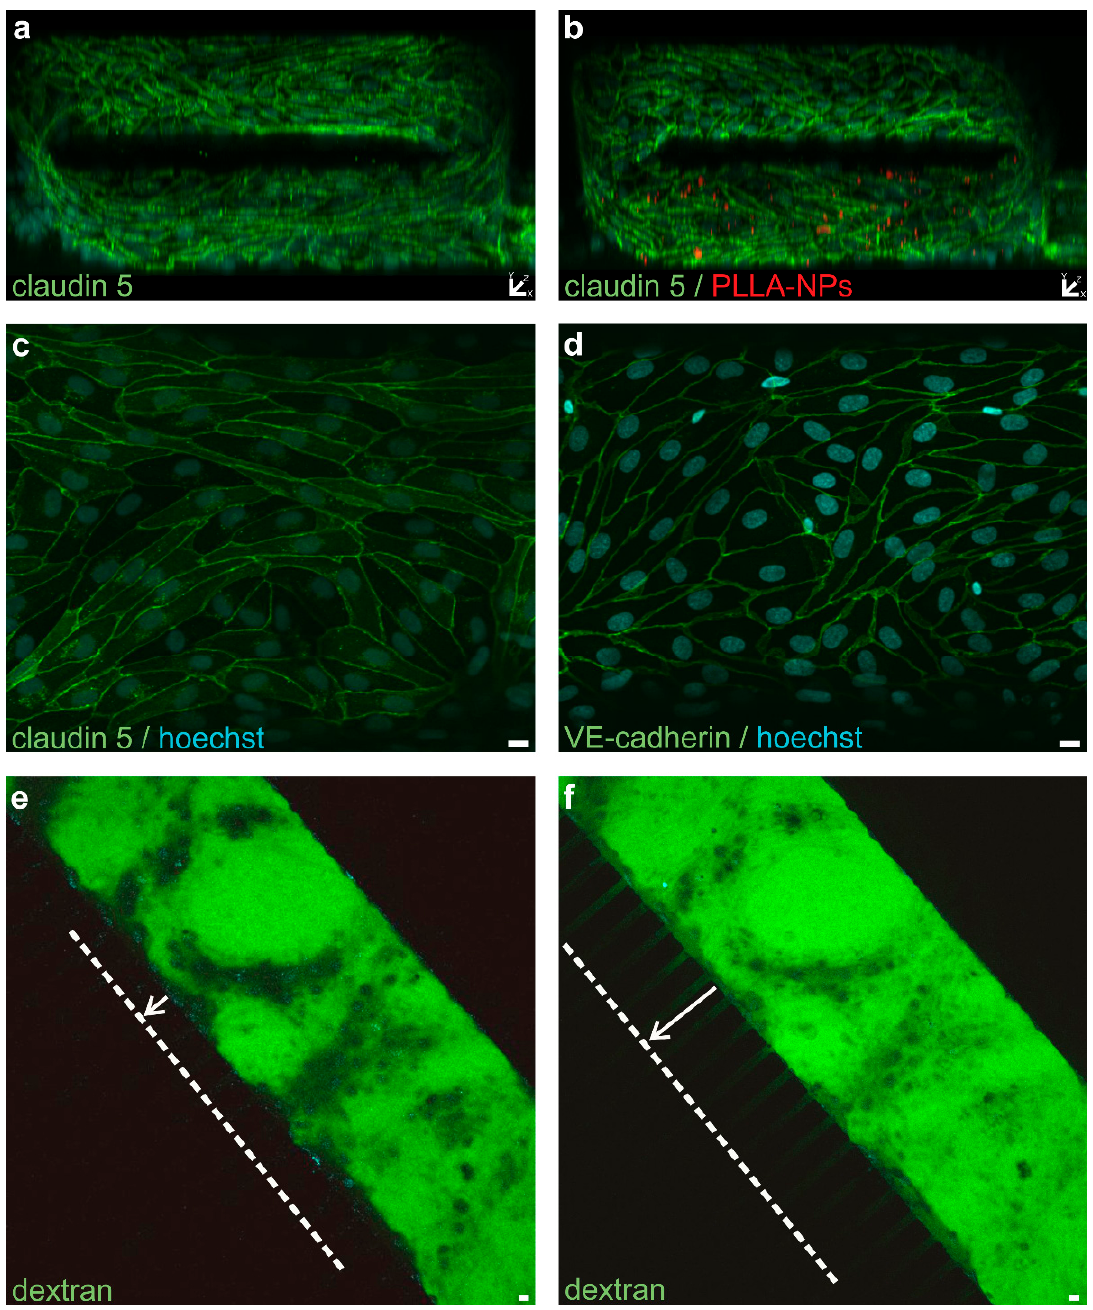
Figure 8. Representative confocal microscopic images of the 3D co ‐ culture model of the blood ‐ brain barrier. Only the endothelial cell compartment is depicted. Confluent monolayers of hBLECs line the lumen of the 3D tube structure in the 3D reconstruction ( a , b ). Cells were stained for claudin ‐ 5 (green) ( a , b ). hBLECs were exposed to PLLA ‐ NPs (24.9 μ g/mL) (red) for 24 h ( b ). Formation of claudin 5 ( c ) and VE ‐ cadherin ( d ) (green) after a co ‐ culture period of 7 days. Leakage of 40 kDa dextran (10 μ M) (green) across the endothelial layer into the migration channels after addition of the tracer solution ( e ) and 12 min later ( f ). The dotted white lines and the white arrows mark the dextran migration into the migration channels. Cell nuclei were counterstained with Hoechst (blue). Scale bars: 10 μ m.